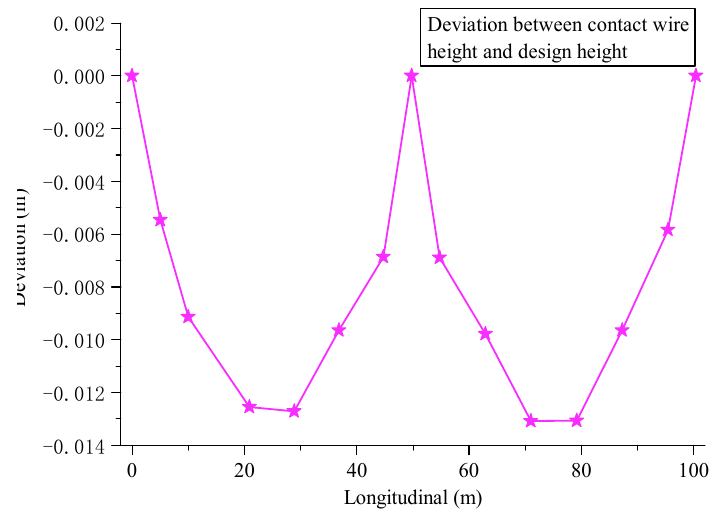
Figure 16. The partial results of the height deviation of the contact wire.